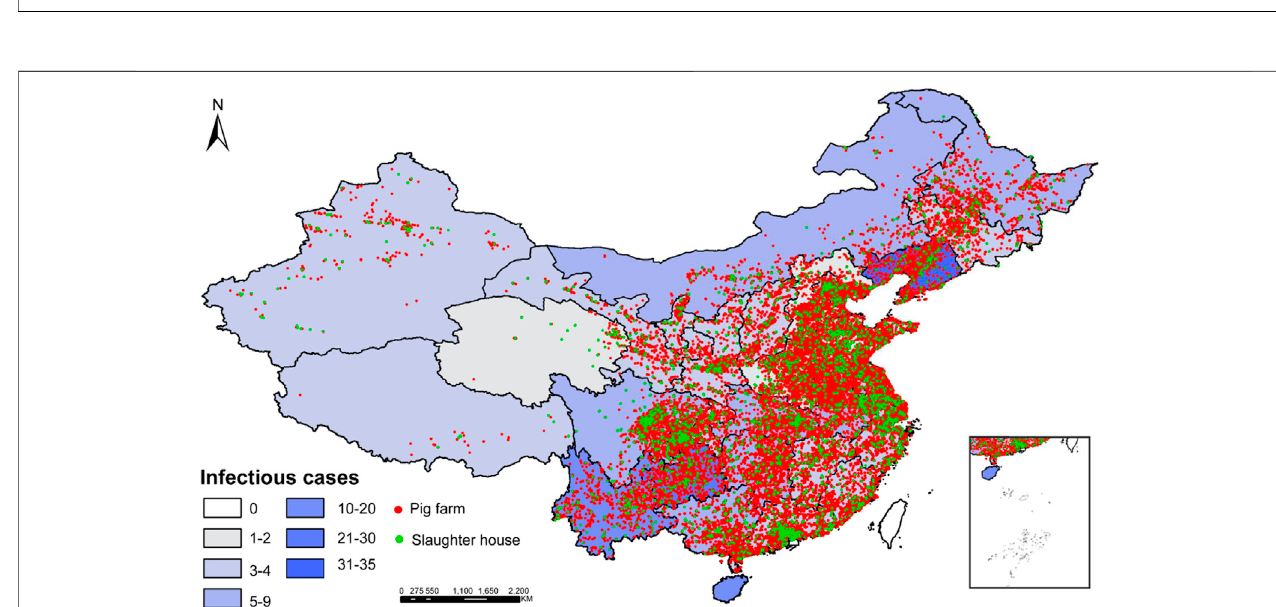
FIGURE 3 | GIS visualization map of the extracted pig farms and slaughterhouses based on the Python language.